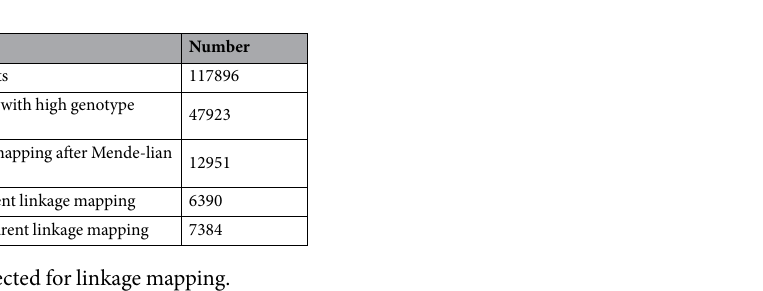
Table 2. Markers selected for linkage mapping.